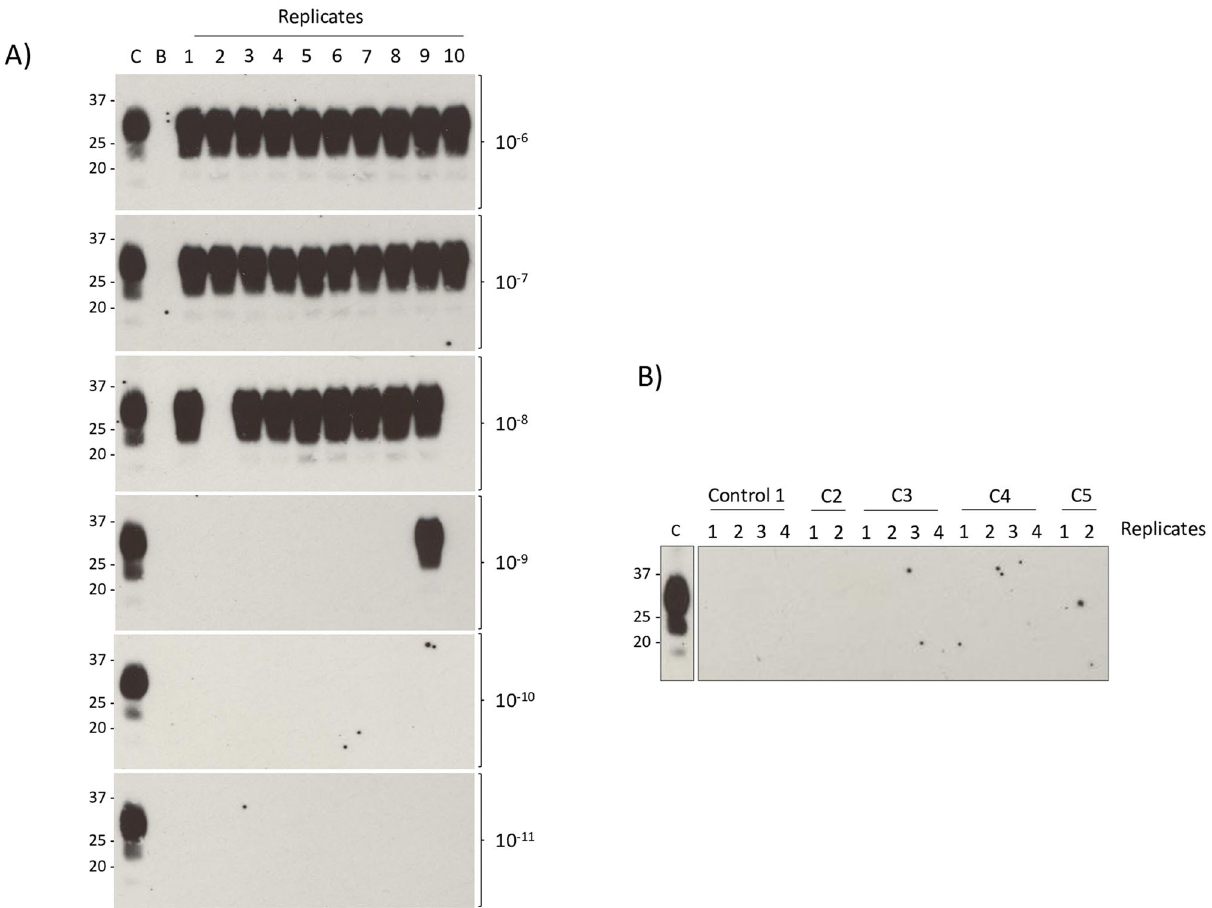
Figure 1. Limits of detection of PrP Sc in prescapular lymph node from a pathology positive sheep. ( A ) Tenfold dilutions of PSLN homogenate (10 –6 to 10 –11 ) from a BSE-infected recipient sheep (M525) were used to seed PMCA reactions, with 10 replicates at each dilution. Following two rounds of PMCA, reaction products were tested for the presence of PK-resistant PrP Sc by Western blotting. C—positive control; BSE-infected sheep brain homogenate (PK digested; 1.7 mg brain equivalent). B—blank lane. ( B ) Negative controls that were run in the same plate. Controls included: C1—substrate only, C2—substrate plus dextran, C3—prescapular lymph node from a mock-infected sheep (N170), C4—brain homogenate from the same mock-infected sheep (N170), C5— brain homogenate from another mock-infected sheep (P457). C—positive control—PK-treated unamplified brain homogenate from BSE-infected sheep (1.7 mg brain